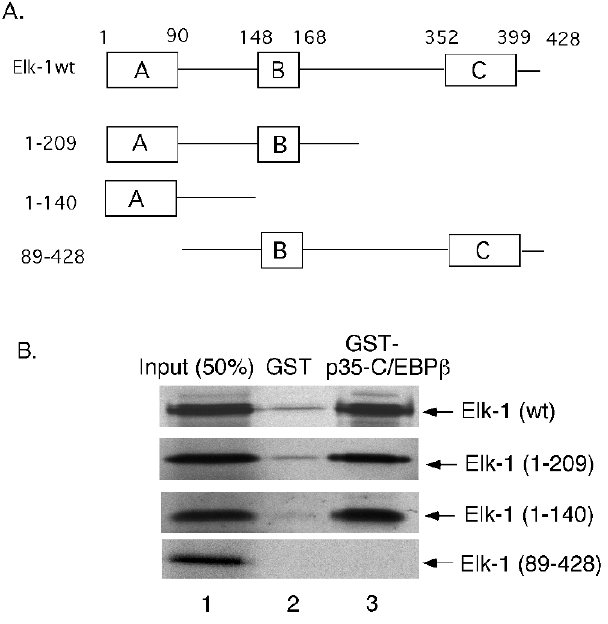
Figure 6 The A-box of Elk-1 is necessary for interaction with p35-C/ EBP β in vitro . A) Schematic representation of Elk-1 wild-type and deletion mutants. B) Radiolabeled Elk-1(wt), Elk-1(1- 209), Elk-1(1-140), and Elk-1(89-428) were prepared by in vitro transcription and translation of their respective expres- sion constructs (see Mat. and Meth.). The proteins were incubated with equivalent amounts of GST or GST-p35-C/ EBP β protein immobilized on glutathione-Sepharose. Pro- teins eluted from the GST beads (lanes 2) or GST-p35-C/ EBP β beads (lanes 3) were resolved on an SDS-10% polyacr- ylamide gel and detected by autoradiography. Lane 1 contains one-half of the amount of the radiolabeled proteins initially mixed with the